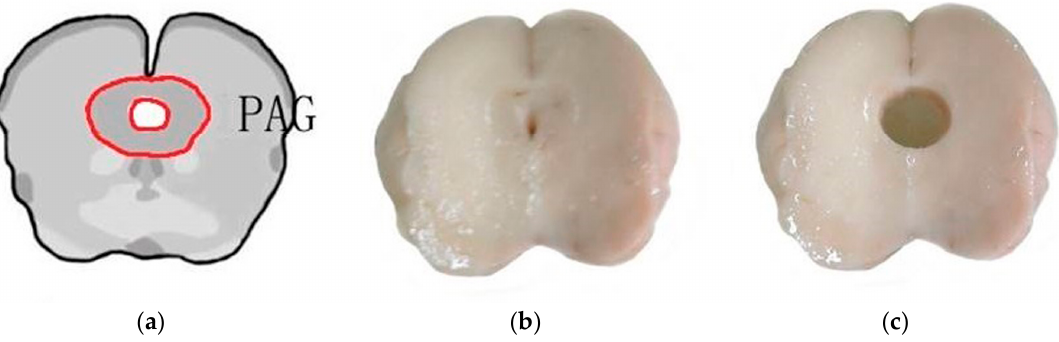
Figure 7. The location of the periaqueductal gray (PAG). ( a ) The sketch of the PAG location; ( b ) The brain section containing the PAG; ( c ) The brain section after sampling.